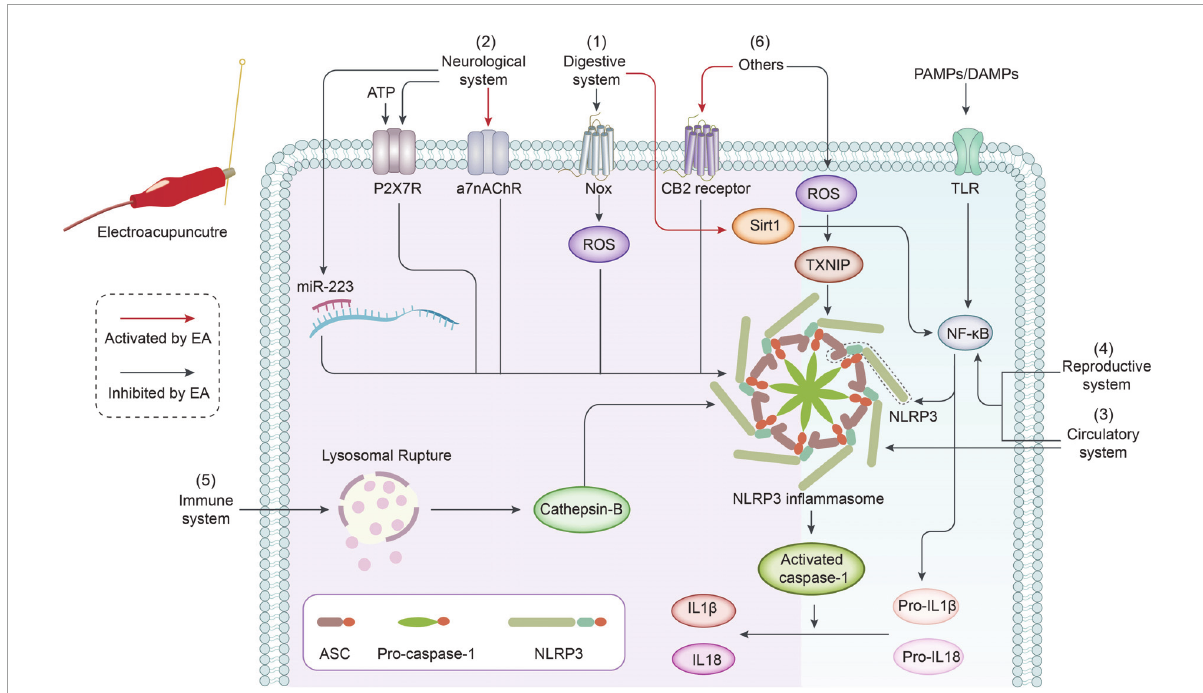
FIGURE1 Summary of mechanisms of electroacupuncture targeting NLRP3 inflammasome in treatment of various diseases. The common point is that electroacupuncture can treat diseases by inhibiting the expression of NLRP3, thereby down-regulating the expression of pro-inflammatory factors IL-18 and IL-1 β (Shi et al., 2020). Digestive system: electroacupuncture inhibits NOX/ROS/NLRP3 pathway; electroacupuncture inhibits NF- κ B/NLRP3 pathway by enhancing the expression of Sirt1 (Xie et al., 2021). Neurological system: electroacupuncture inhibits ATP/P2X7R/NLRP3 and miR-223/NLRP3 pathway; electroacupuncture inhibits NLRP3 inflammasome by enhancing the expression of a7nAChR (Meng et al., 2018). Circulatory system: electroacupuncture inhibits the activation of NLRP3 inflammasome by down-regulating the expression of NLRP3, ASC, and pro-caspase-1; electroacupuncture inhibits NF- κ B/NLRP3 pathway (Zhu et al., 2015). Reproductive system: electroacupuncture inhibits NF- κ B/NLRP3 pathway (Zhang et al., 2017). Immune system: electroacupuncture inhibits NLRP3 inflammasome